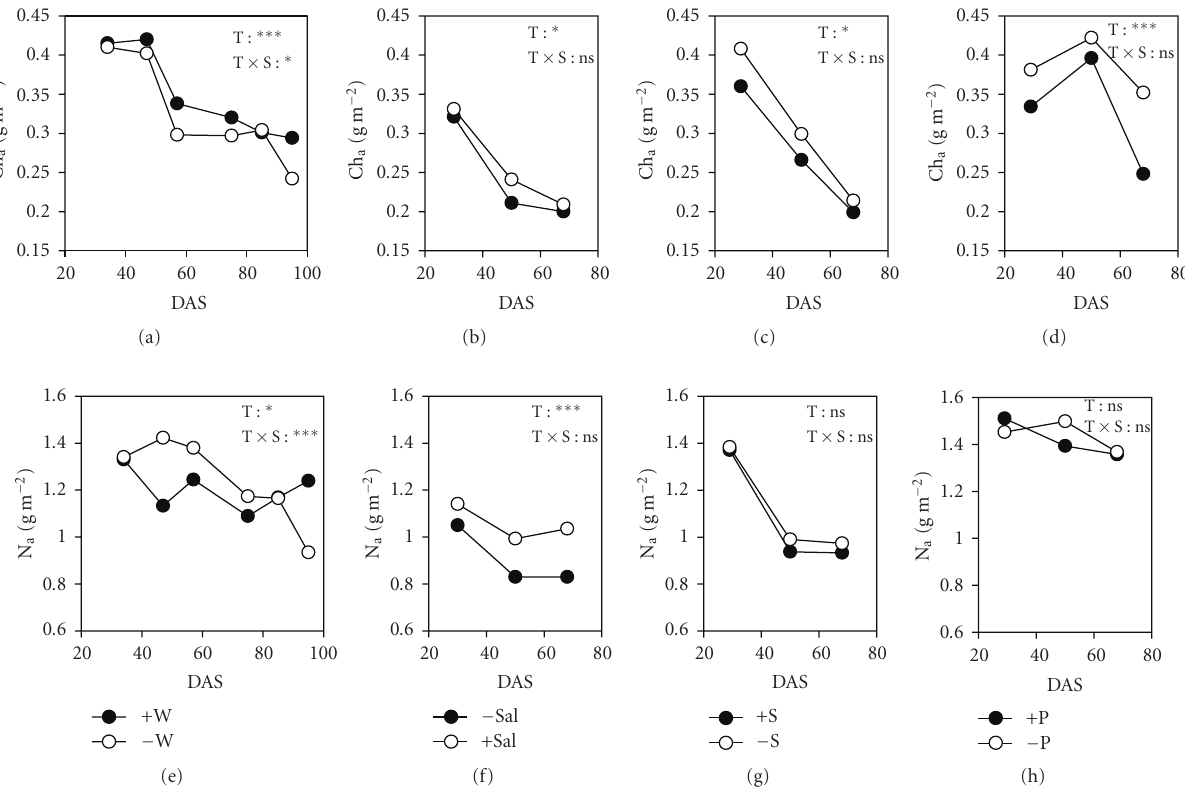
Figure 5: Seasonal dynamic of area-based leaf chlorophyll concentration (Ch a ) and leaf N concentration (N a ) for all treatments. Stress treatments applied were drought (–W), salinity (+Sal), sulfur deficiency (–S), and phosphorus deficiency (–P). Shown are mean treatment values for three replications and all varieties used because no significant interaction was detected. Significance levels for treatment (T) e ff ects and treatment by sampling time interaction (T × S) are ns = P > . 05; ∗ : . 05 ≤ P ≤ . 01; ∗∗ : . 01 ≤ P ≤ . 001; ∗∗∗ : P < . 001 (further details in Tables 3 and